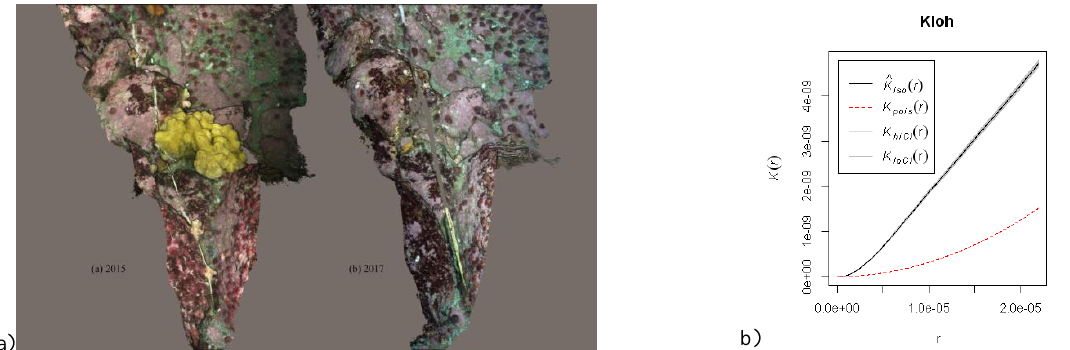
Figure 5. (a) A large demospongia well recognizable in T2_PNRA2015 transects (left) completely disappeared in2017 (right). (b) A K-Ripley function graph representing S. neumayeri distribution in transect T2_PNRA_2015. Dotted red line represent the typical K-Ripley curve of a random distributed population, while black line (with confidence interval in grey) represents the S.neumayeri distribution in the transect and shows a slope indicating a clustered